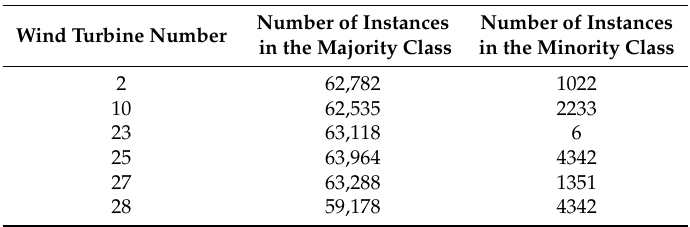
Table 1. Data set